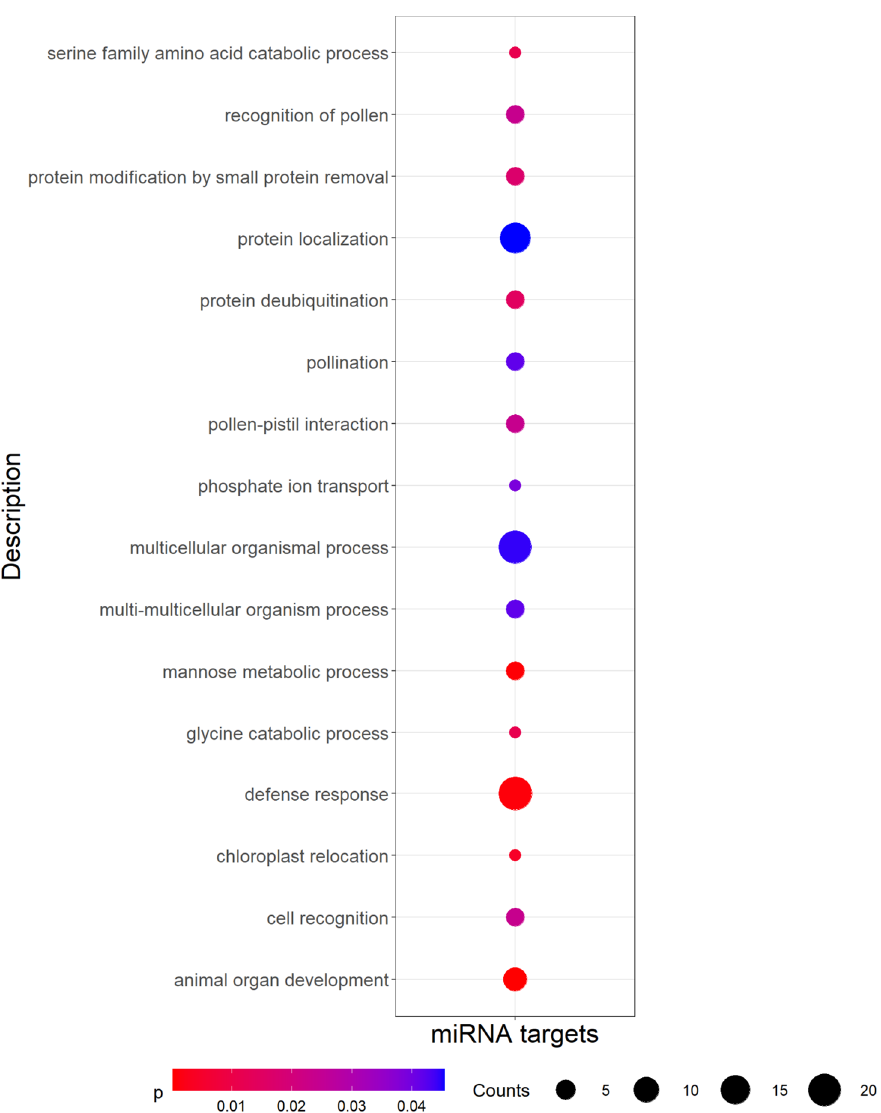
Figure 3. Significantly ( p -value < 0.05) enriched Gene Ontology (GO) biological process terms among miRNA targets. Counts indicate the number of targets annotated with each GO term, and dots are colored by p -value.